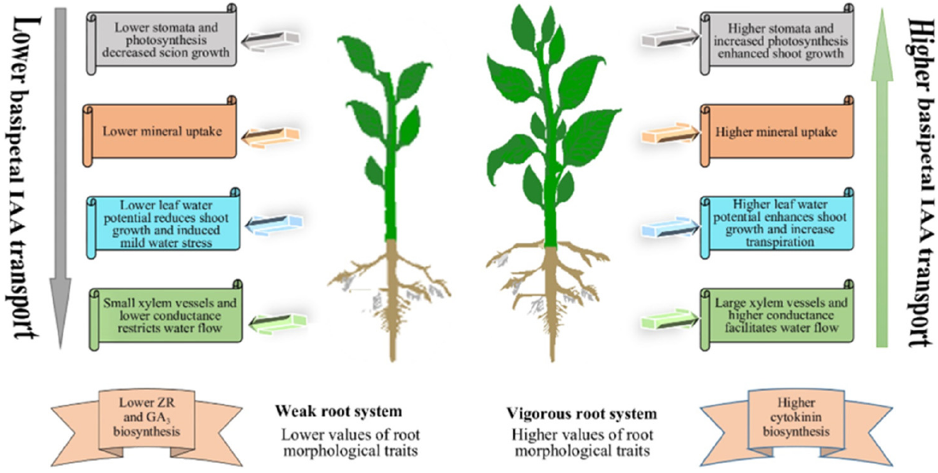
Figure 1. Schematic diagram of rootstock-control scion vigor [41].